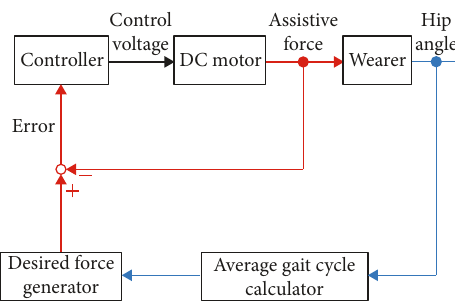
Figure 3: Block diagram of a tension force control scheme.